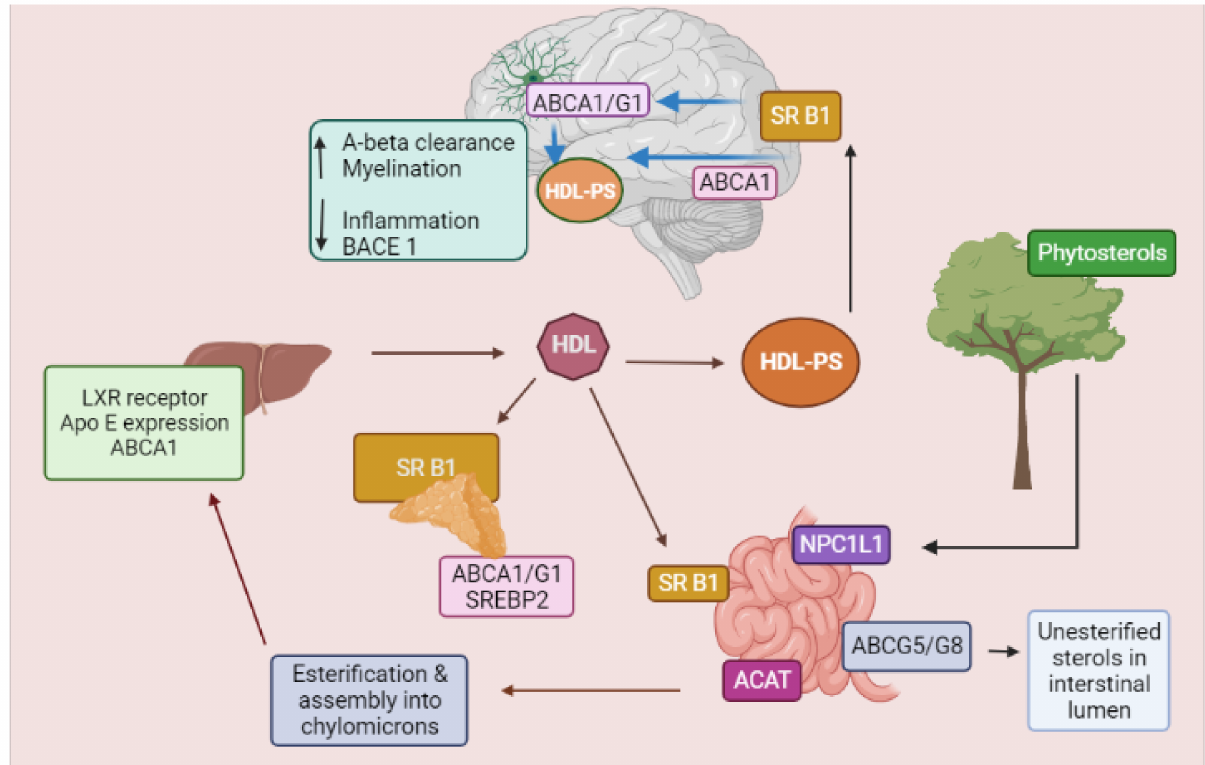
Figure 2. Pathway of dietary phytosterol assimilation in humans. Phytosterols and dietary cholesterol are mainly absorbed in the intestine through NPC1L1 transporter. After absorption, sterols are esterified by ACAT and transported to the liver in the form of chylomicrons. The unesterified sterols are pumped out by ABCG5/ABCG8 transporters. The plasma efflux of sterols is regulated by ABCA1, which is involved in the assembly of HDL-like particles with the assimilated sterols. In liver, phytosterols stimulate LXR receptors regulating ApoE expression required for HDL and LDL assembly and uptake. Stimulated LXR receptors upregulate ABCG5/G8 transporters and augment sterol absorption. The exported HDL-like particles containing phytosterols are taken up by SR-IB receptors expressed on the liver, adrenal, and brain surface. SR-B1 has a crucial role in the flux of phytosterols across the BBB. ABCA1/ABCG1 transporters present on astrocytes and the basolateral side of the cerebral endothelium also assist in the transfer of phytosterols. Inside the brain, PS exert a positive effect on brain function by escalating A- β plaque clearance, increasing re-myelination besides reducing neuro inflammation and BACE 1 activity. Abbreviations: ABC, ATP-binding cassette transporters; A- β , Amyloid- β ; ACAT, Acyl-coenzyme A cholesterol acyl transferase; ApoE, Apolipoprotein E; BACE1, β -Secretase 1; HDL, High-density lipoprotein; SR-B1, Scavenger receptor class B type 1; LDL, Low-density lipoprotein; LXR, Liver X receptor; NPC1L1, Niemann-Pick C1 like 1 protein; PS,